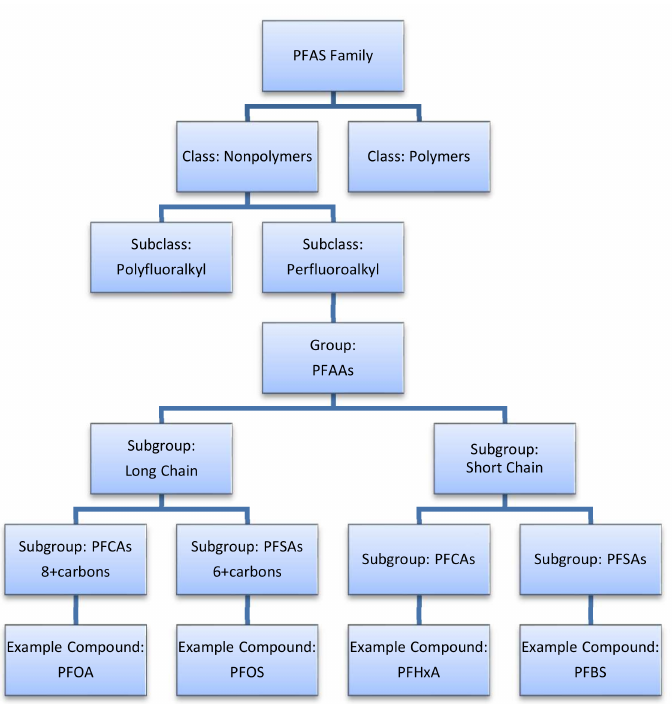
Figure 1. Overview of the major families of PFAS (per- and polyfluoroalkyl substances), including: PFAAs (perfluoroalkyl acids), 8 or more carbon PFCAs (perfluoroalkyl carboxylic acids/perfluoroalkyl carboxylates), PFOA (perfluorooctanic acid), 6 or more carbon PFSAs (perfluoroalkane sulfonic acids/perfluoroalkyl sulfonates), PFOS (perfluorooctane sulfonate/perfluorooctane sulfonic acid), 6 or fewer carbon PFCAs (perfluoroalkyl carboxylic acids/perfluoroalkyl carboxylates), PFHxA (perfluorohexanoate/perfluorohexanoic acid), 5 or fewer carbon PFSAs (perfluoroalkane sulfonic acids/perfluoroalkyl sulfonates), and PFBS (perfluorobutane sulfonate/Perfluorobutane sulfonic